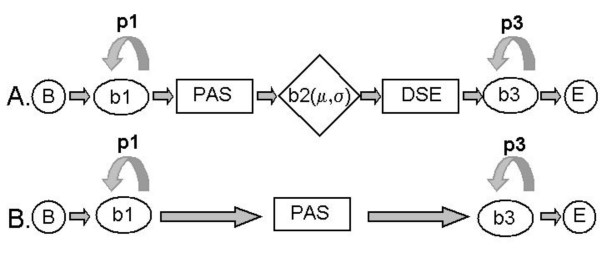
HMM models used to predict mRNA termination. A: Double model used in specificity tests and mRNA CS predictions (Figure 5). Both PAS and DSE separated by a Gaussian spacer must be used. Zeroth-order emission probabilities are b1 and b3, and self-transitions p1 and p3. In the Gaussian spacer the emission probability is b2. In both models b1 = b2 = b3. B: PAS-only model: control model including a single weight matrix.